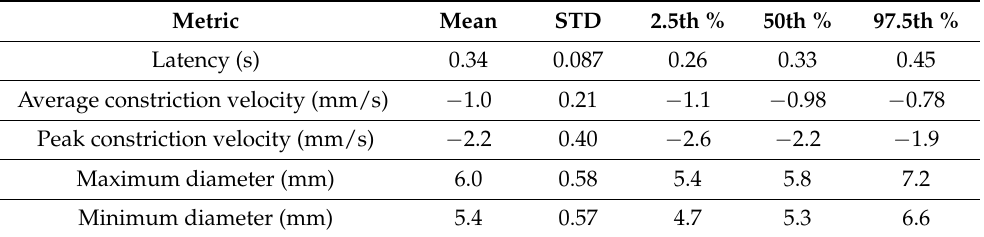
Table A1. Mean, standard deviation, and 2.5th, 50th, and 97.5th percentiles of pupillary response metrics from healthy animals (N = 13).